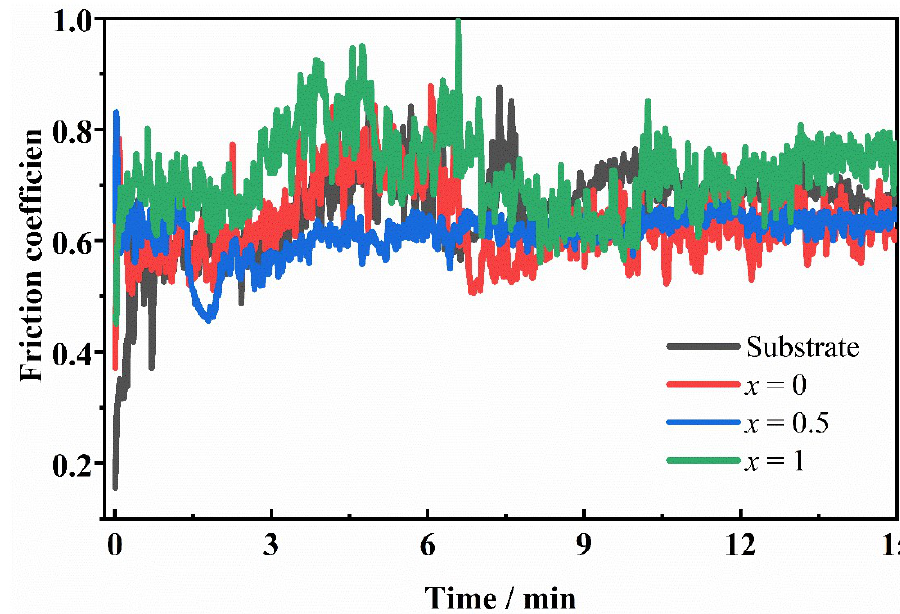
Figure 7. Friction coefficient curves of Al x Ti 1− x ( x = 0, 0.5, 1) coatings, also taking the commercial 904L stainless steel into account as a comparison.